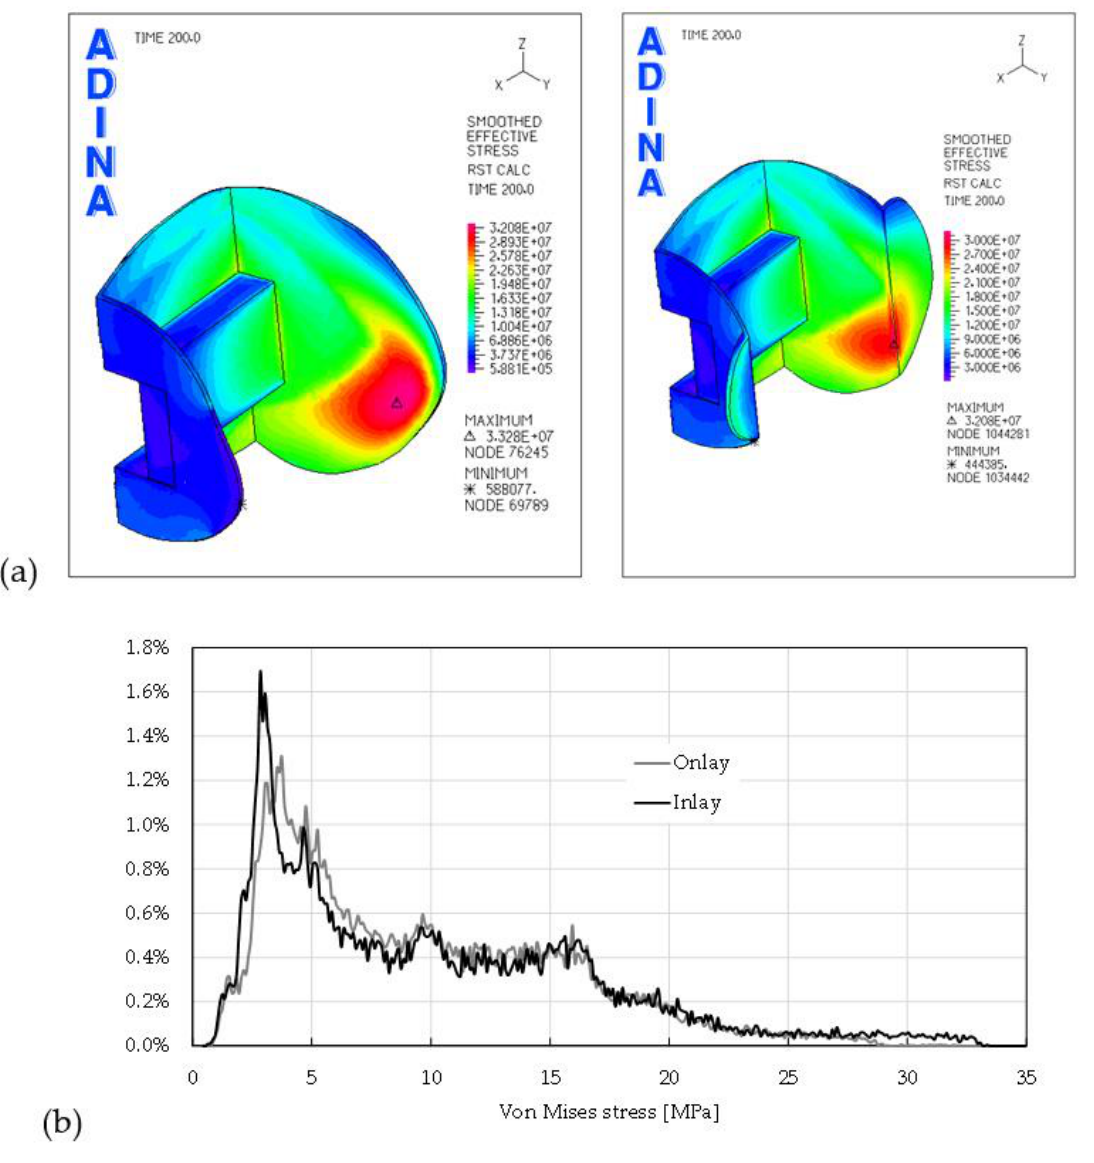
Figure 5. Smoothed stress distributions for the adhesives of both models. ( a ) Inlay (left) and onlay (right). ( b ) Histograms of the distributions for both